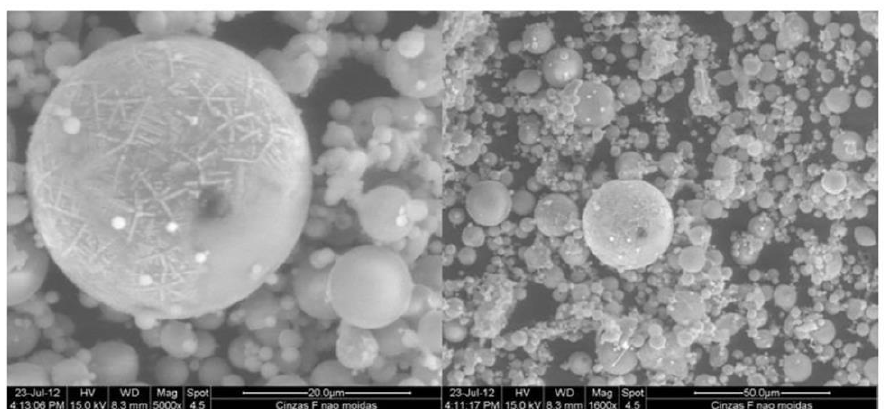
Figure 6. Mineralogical composition of the fly ash obtained by XRD.